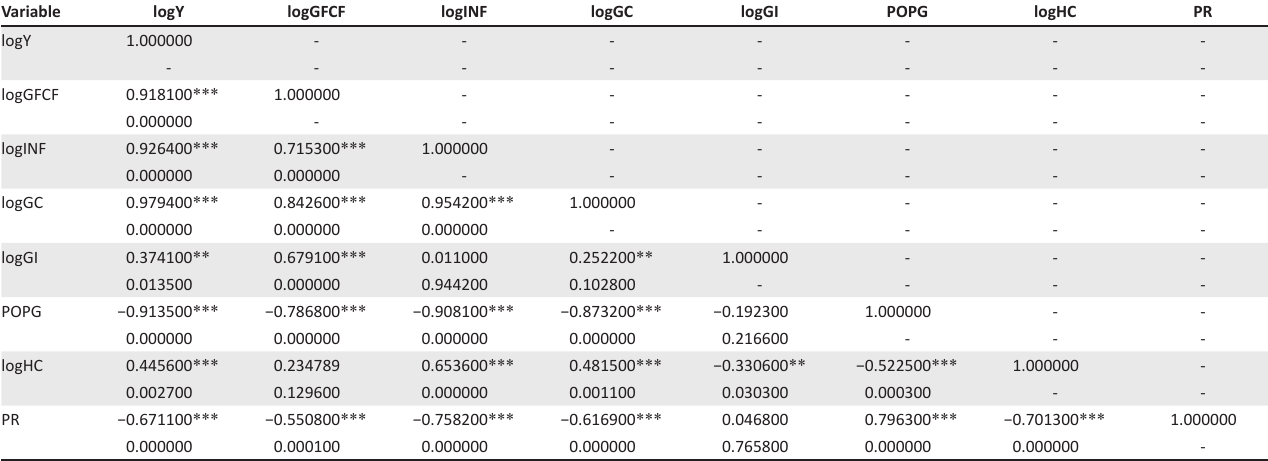
TABLE 2: Correlation probability.